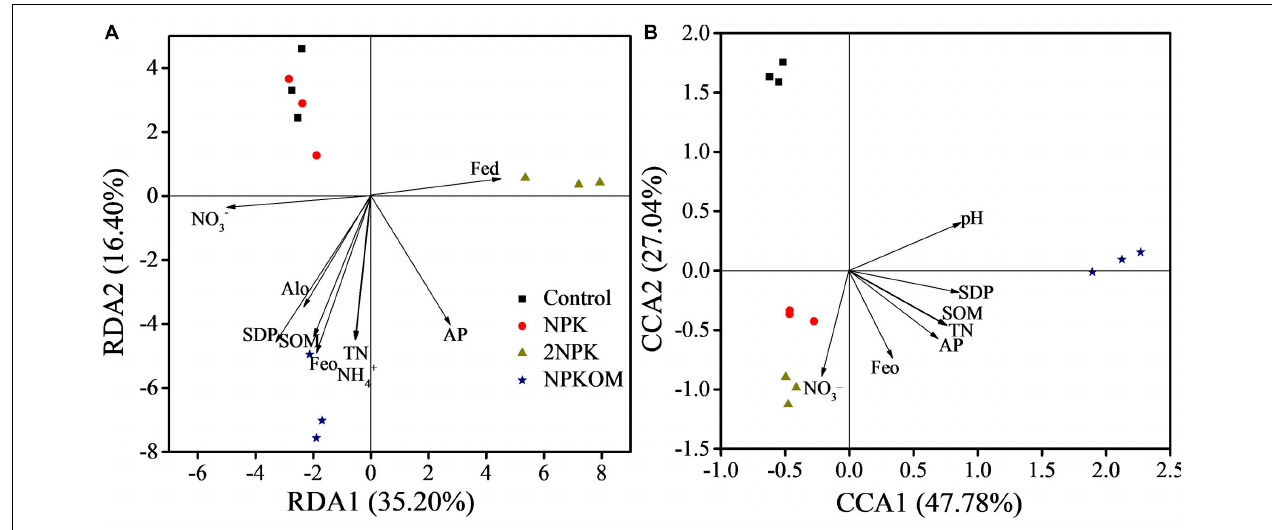
FIGURE 4 | Redundancy analysis (RDA) of the correlation between nirS -denitrifying bacterial communities and soil properties and SDP in the paddy soil (A) . Canonical correlation analysis (CCA) of correlations between nirS -denitrifying bacterial communities and soil properties and SDP in the upland soil (B) . Soil properties presented in (A,B) significantly affected the nirS -denitrifying bacterial communities assessed by the Monte Carlo